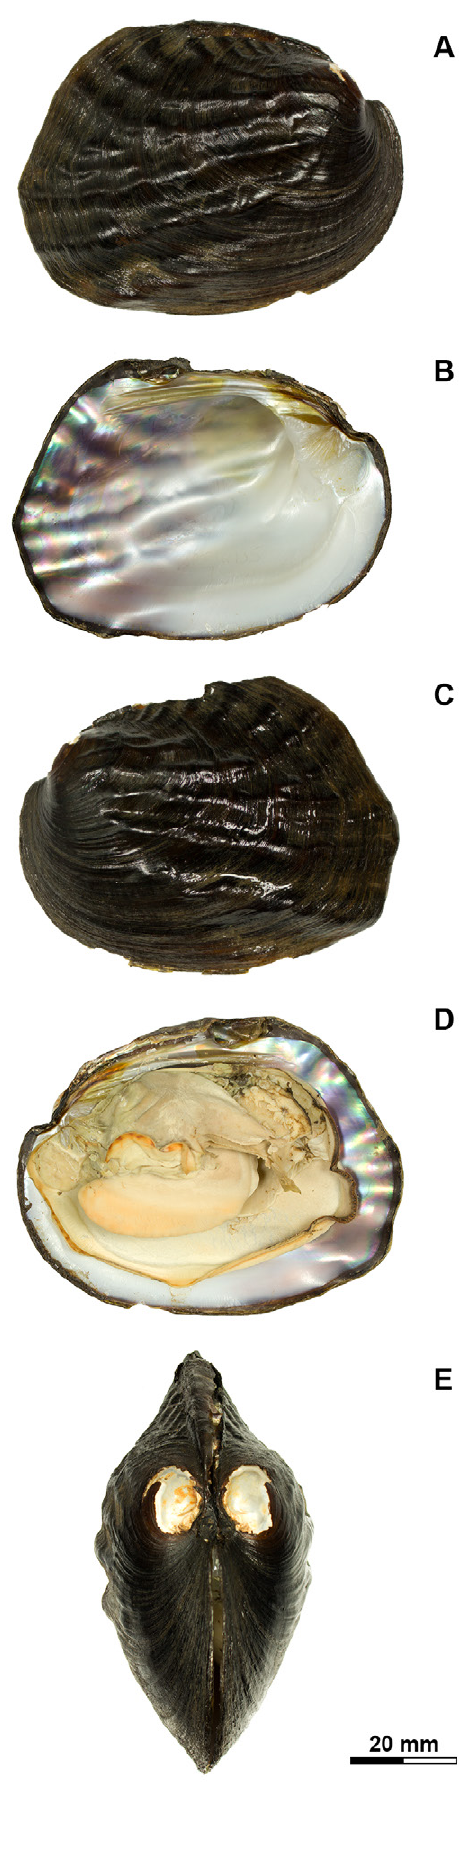
► Figure 1. Amblema plicata . UF 439505, length 73 mm. A. Right valve, external view. B. Left valve, internal view. C. Left valve, external view. D. Right valve with soft morphology, internal view. E. Inflatedness, dorsal view. Specimen photo credit: Ava M.